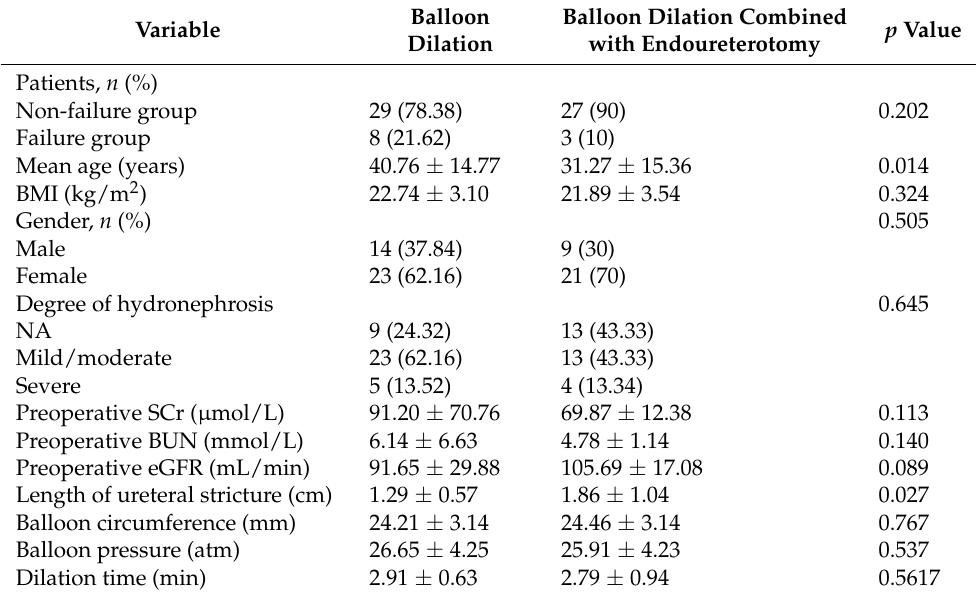
Table 2. Baseline data for patients treated with balloon dilation versus balloon dilation combined with